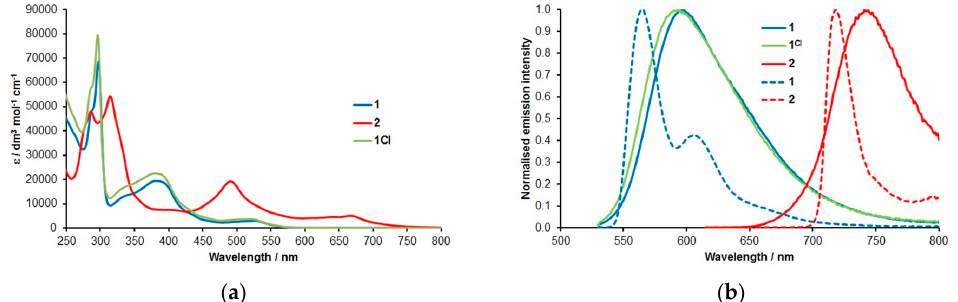
Figure 1. ( a ) UV-visible absorption spectra for 1 and 2 in acetonitrile solutions and 1 Cl in aqueous solution at room temperature; ( b ) normalized emission spectra of complexes 1 and 2 in de-aerated acetonitrile solutions and 1 Cl in aerated aqueous solution at room temperature (solid lines) and complexes 1 and 2 in 4:1 EtOH/MeOH glasses at 77 K (dashed lines). Table 1. Summarised photophysical data for 1 , 1 Cl and 2 in acetonitrile. Complex